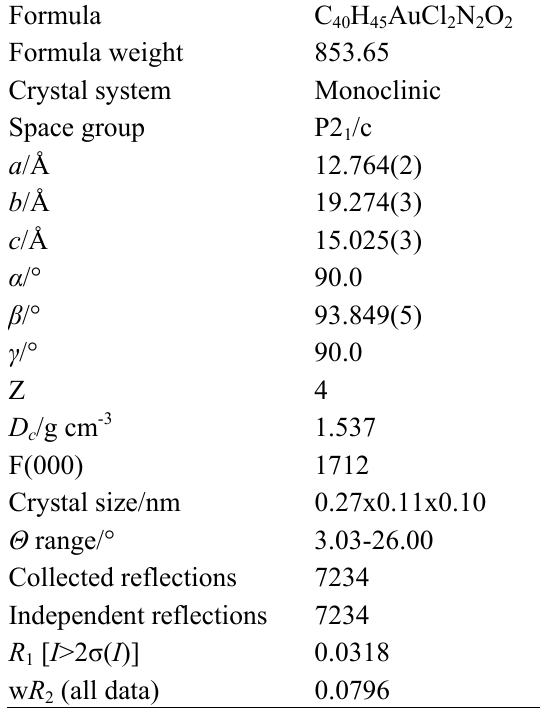
Table 1. Selected crystal data, data collection and refinement parameters for compound 5 .